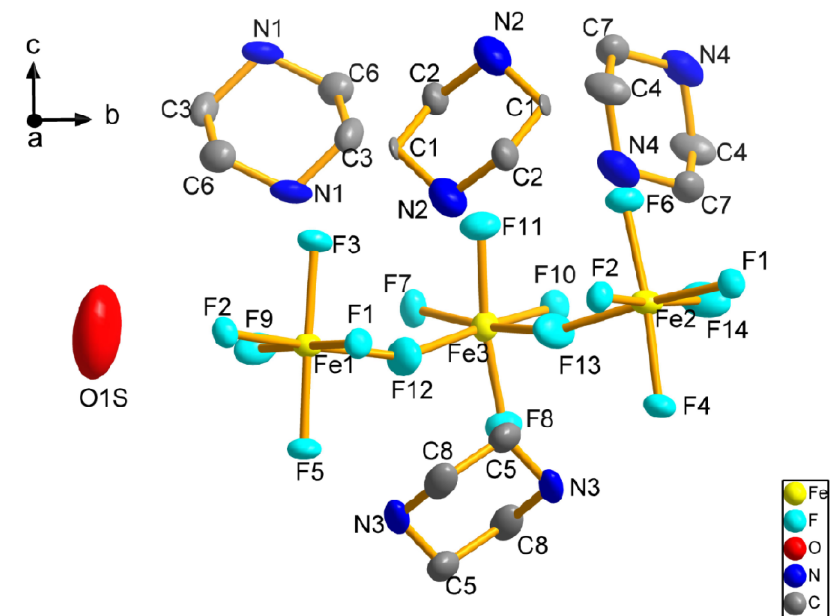
Figure 5. The building unit of 2 (Hydrogen atoms are eliminated for clarity).